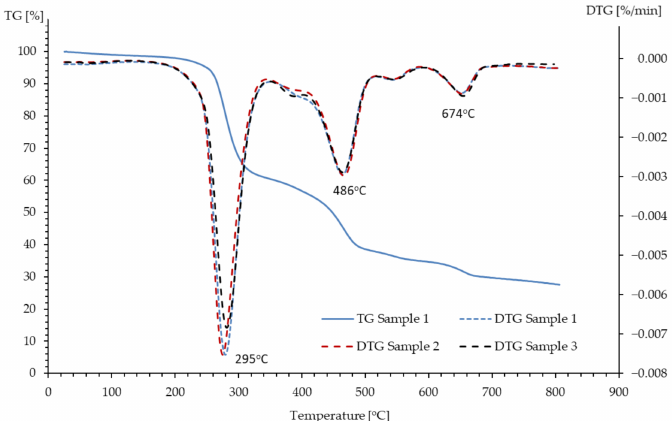
Figure 5. Differential thermogravimetric (DTG) curves for the ASR sample